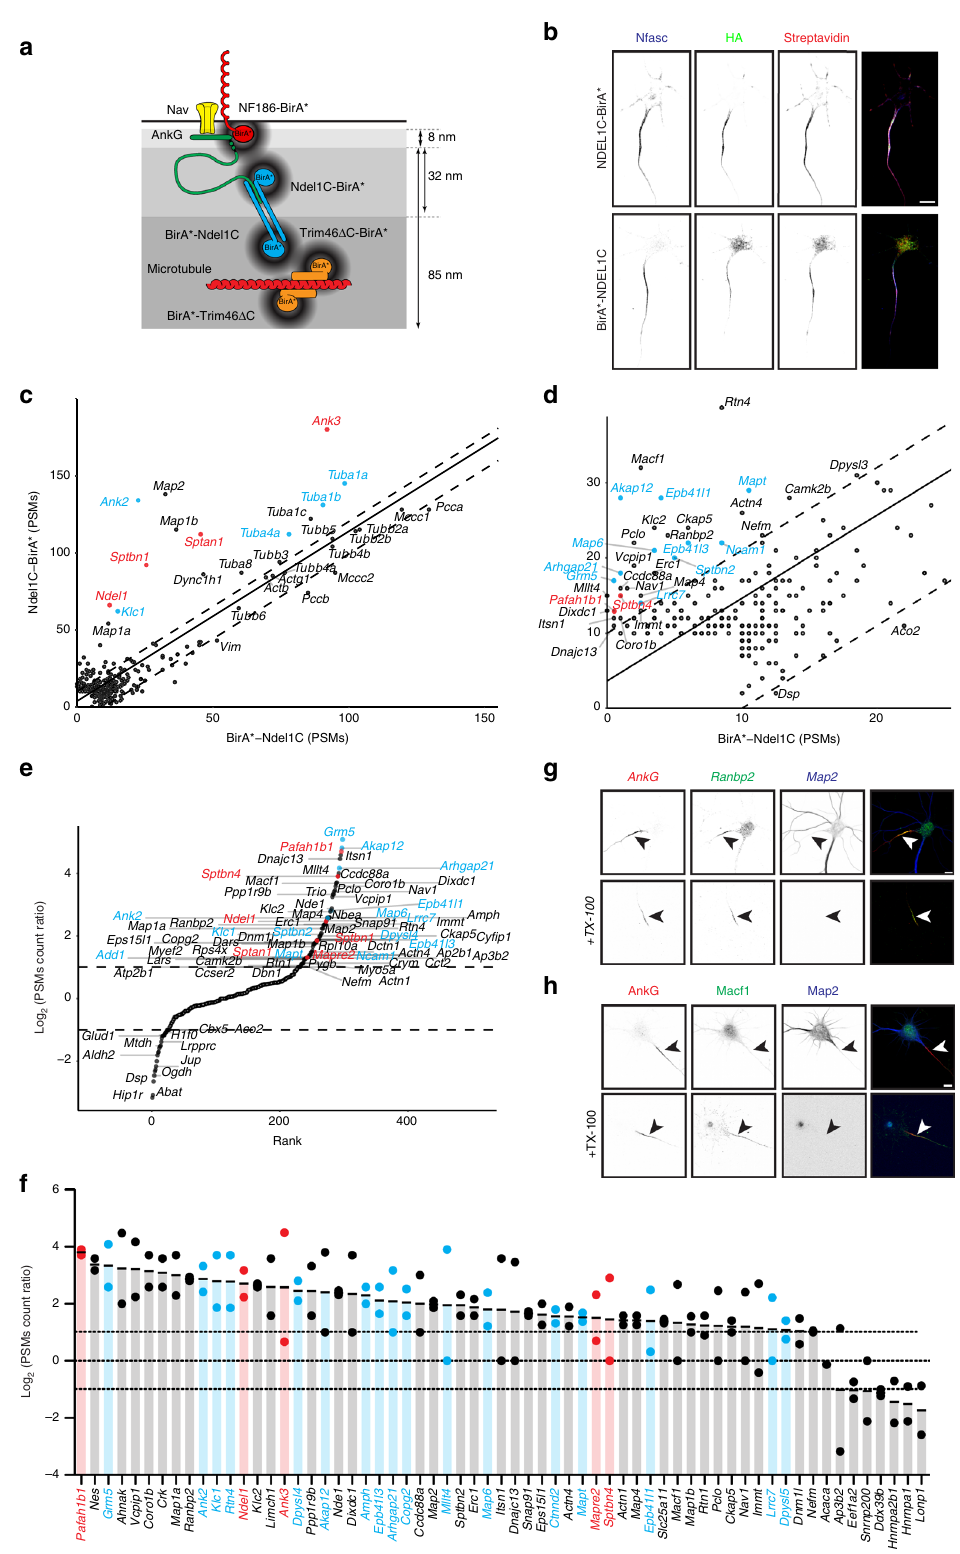
identi fi ed as interacting with AnkG (e.g., β 4 spectrin and Map6; Fig. 8b, c). Since Ndel1 regulates dynein activity along microtubules, and BirA*-Ndel1C is oriented with the BirA* away from AnkG (Fig. 7), we considered whether BirA*-Ndel1C and Trim46-BirA* chimeras biotinylate a similar pool of proteins, resulting in